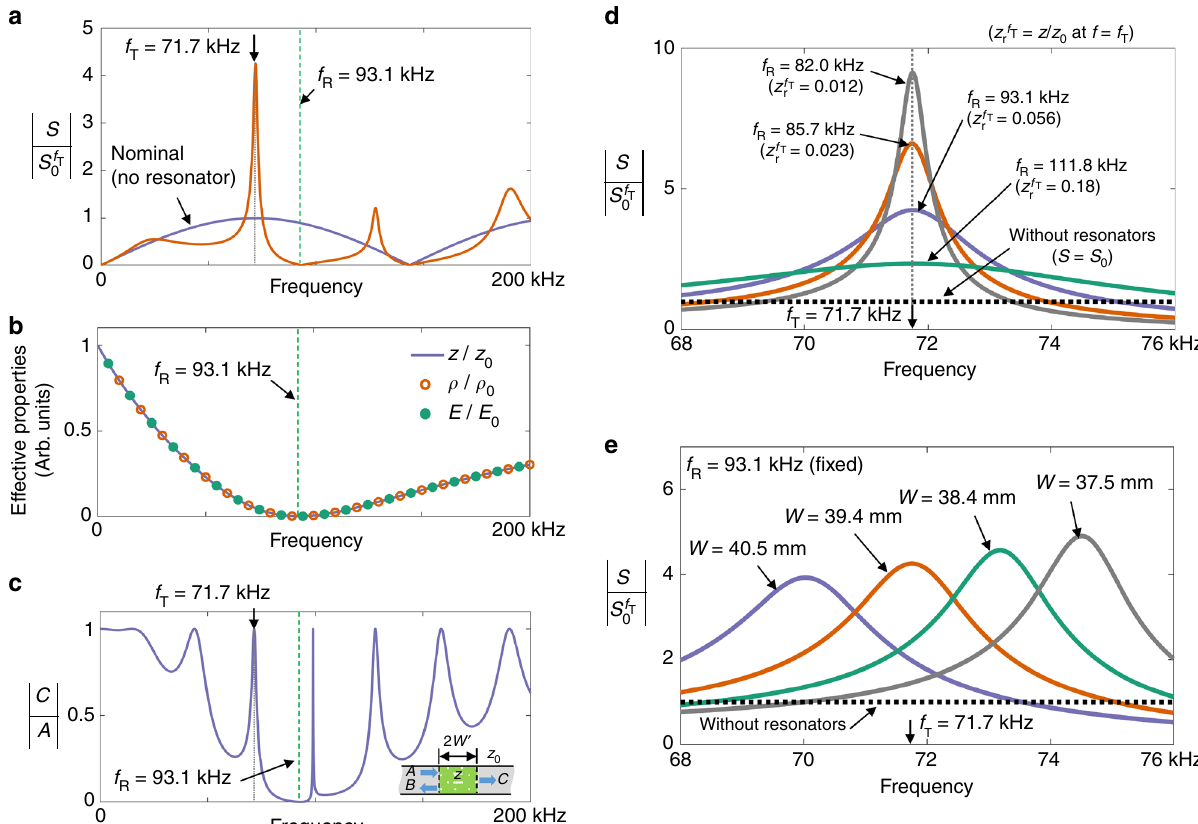
Fig. 3 Variation of key strain fi elds and effective properties as function of frequency. a The radiated strain fi eld | S |, b effective impedance z (density ρ and stiffness E ), c transmission coef fi cient in the bar con fi guration shown in the inset of the bottom illustration, d the effects of the resonance frequency f R on | S |, and e the effects of the distance W between the two resonators on | S